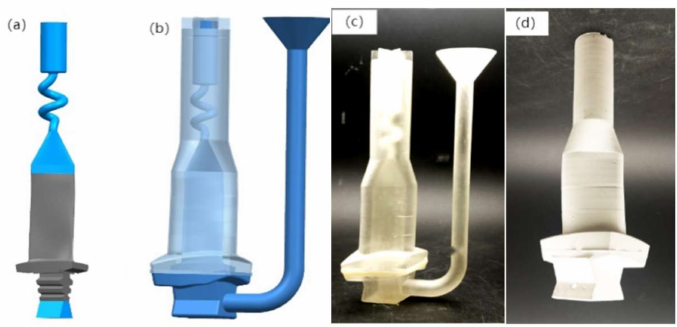
Figure 3. ( a ) Blade model; ( b ) Resin model; ( c ) Resin mold; ( d ) Casting mold.